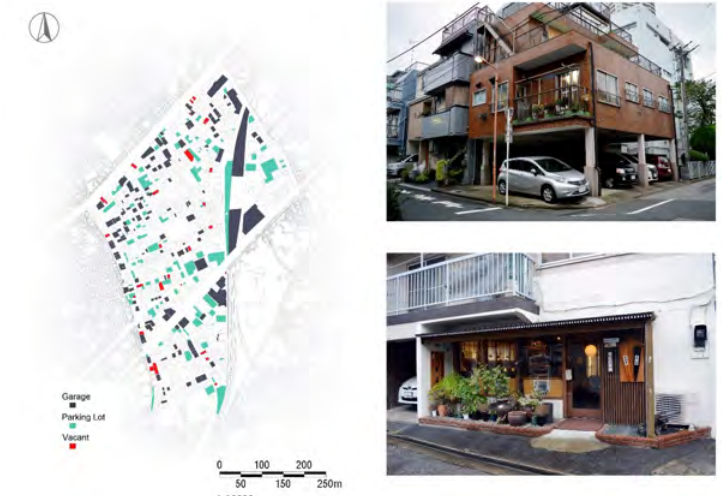
Figure 6. (a) Ineffectivelyused buildings and open spaces plan. (b) House with apassive ground floor. Photo by author. (c) Chopstick shop next to the car-partsfactory. Photo by